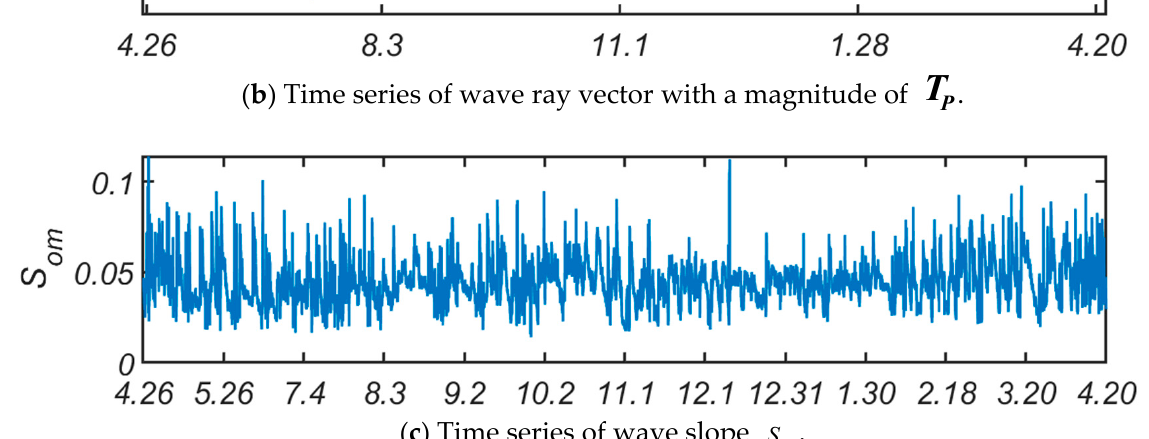
Figure 10. Time series of peak period T P , significant wave height H S , and wave slope S om collected at Mang-Bang from 26 April 2017 to 20 April 2018.